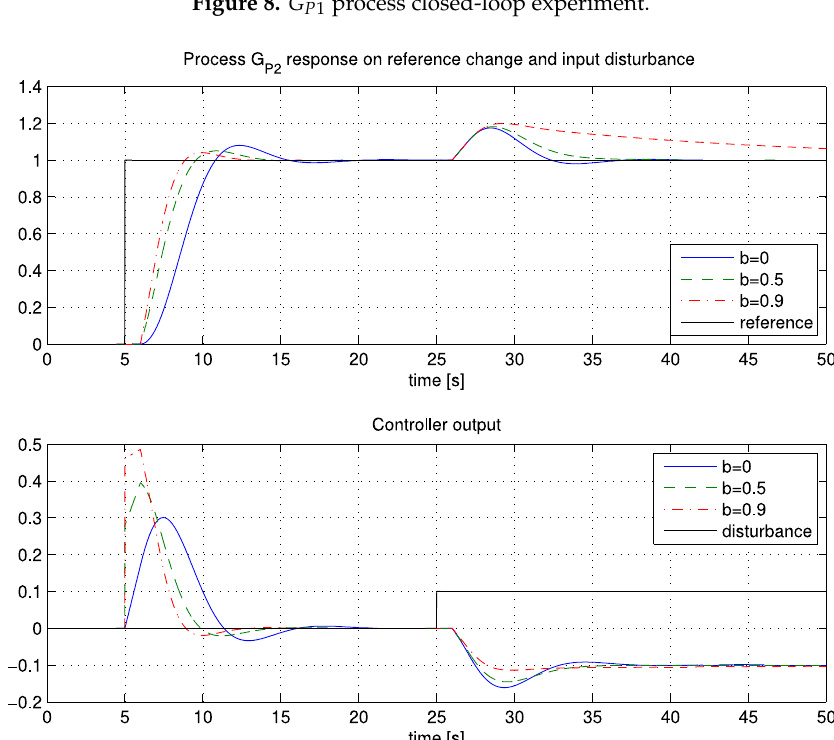
Figure 9. G P 2 process closed-loop experiment.